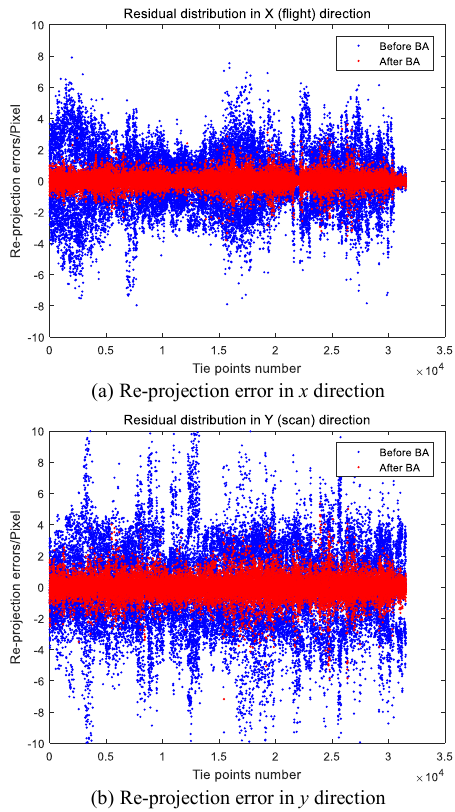
Figure 1. Re-projection error of tie